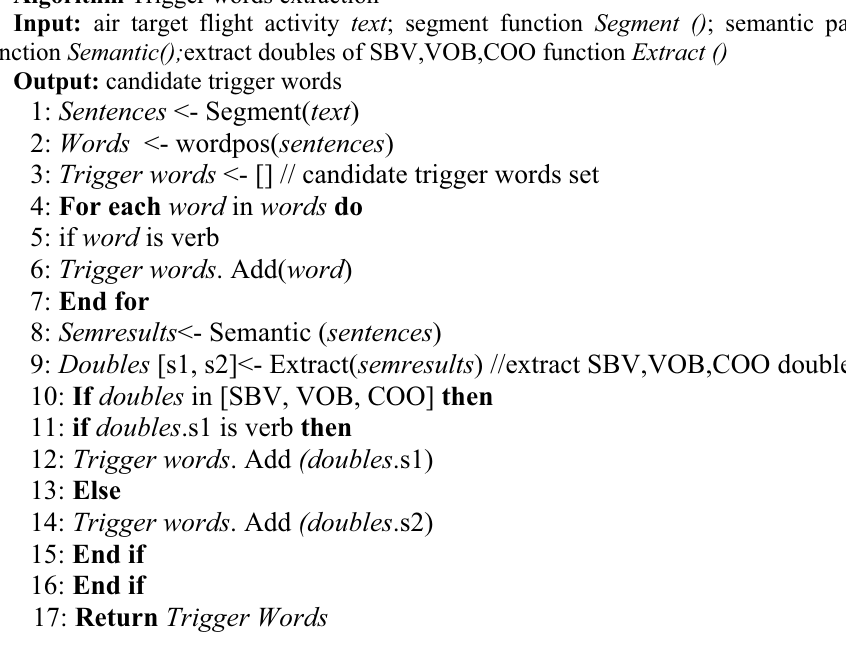
Algorithm Trigger words